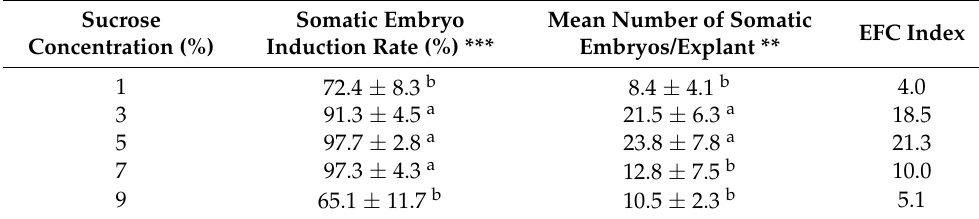
Table 2. Effect of sucrose concentration in induction medium on somatic embryogenesis of P. ginseng .